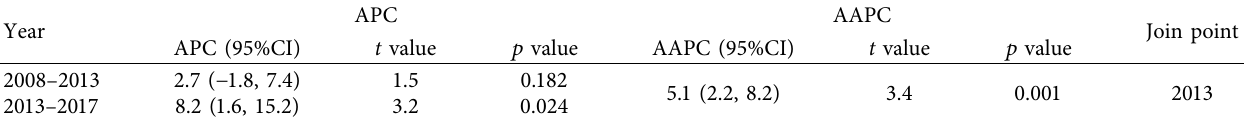
Abbreviations: ASR, age-standardized mortality rate. Table 2: APC and AAPC of the crude incidence of female breast cancer in urban Shenyang in 2008–2017.